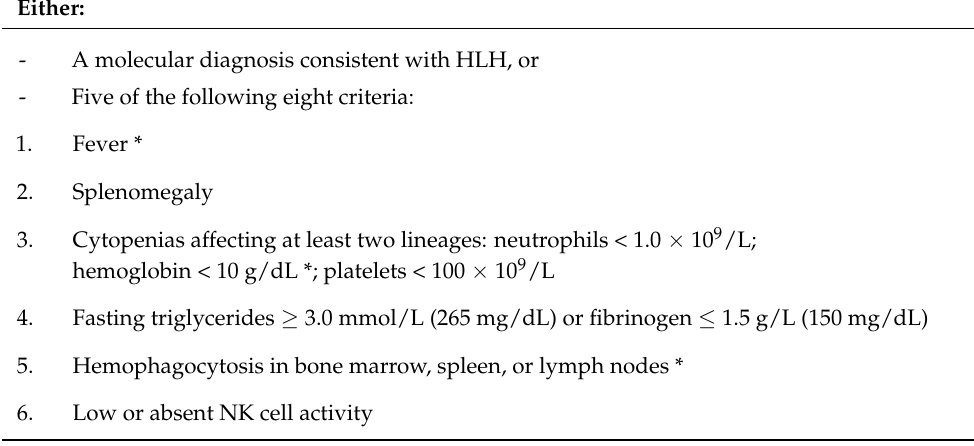
Table 2. HLH-2004 Diagnostic Guidelines for Hemophagocytic Lymphohistiocytosis